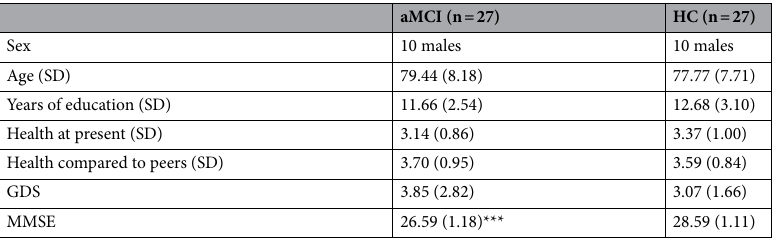
Table 2. Demographic characteristics as a function of group (aMCI vs HC). Health at present (1 = poor, 5 = excellent); Health compared to peers (1 = significantly worse, 3 = same, 5 = significantly better). aMCI amnestic Mild Cognitive Impairment, HC Healthy Controls. Differences between aMCI and HC are indicated by *** p < .001.